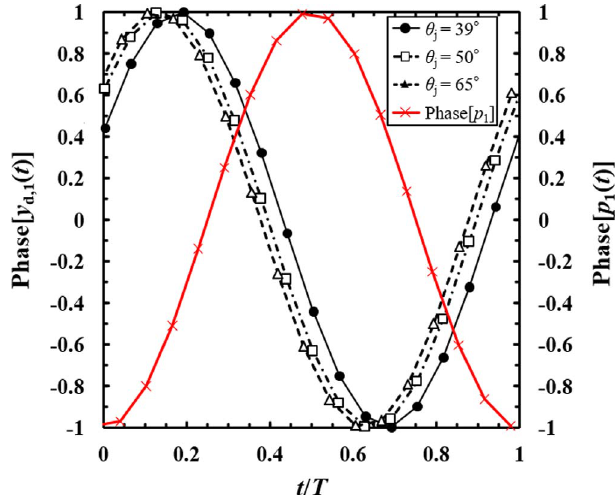
Figure 15. Periodical variations of jet displacements at x h = 1, 2, and 5, as well as periodical sound pressure fl uctuation j / in the resonator. ( h j = 39 (cid:3) , y j,e = 0, l / h = 5.6, Q = 16 L/min).